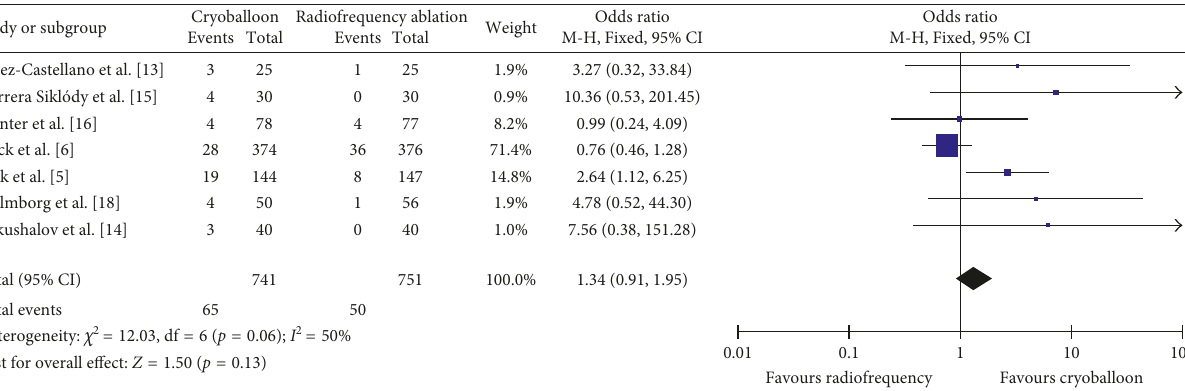
Herrera Sikl´ody et al.